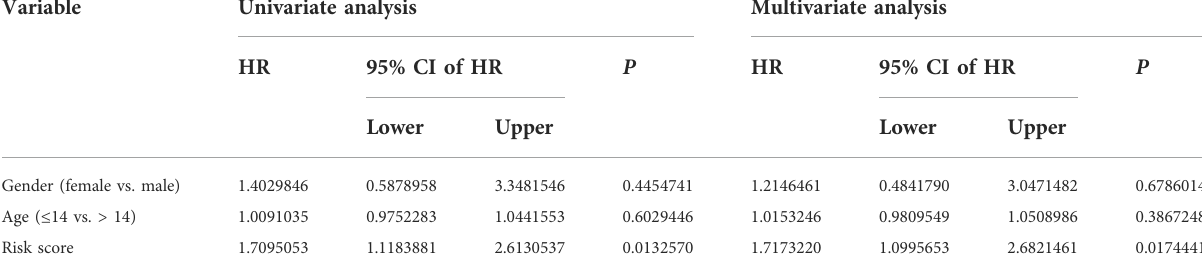
TABLE 2 Univariate and multivariate analyses of the three FAGs ’ prognostic signature and clinical factors in the GSE21257 cohort.